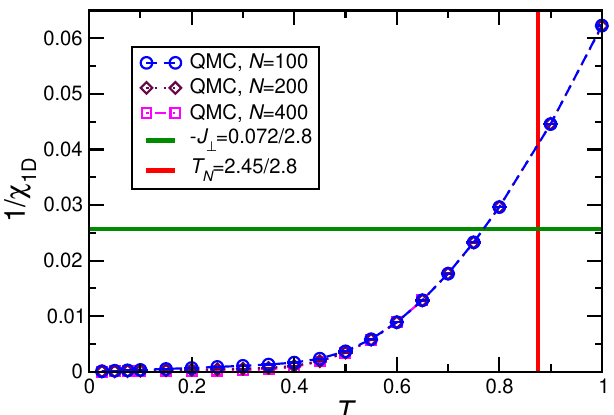
Figure 9. Inverse magnetic susceptibility calculated by QMC for a single chain with D = 0.36/2.8, h = 0, J = 1. Furthermore, also shown are the estimated value of the interchain coupling − J ⊥ = 0.072 K [28] as well as the experimental Néel temperature T J = 2.8